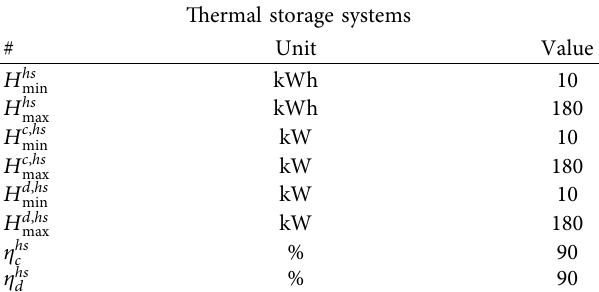
Table 2: Technical parameters of the thermal storage system.